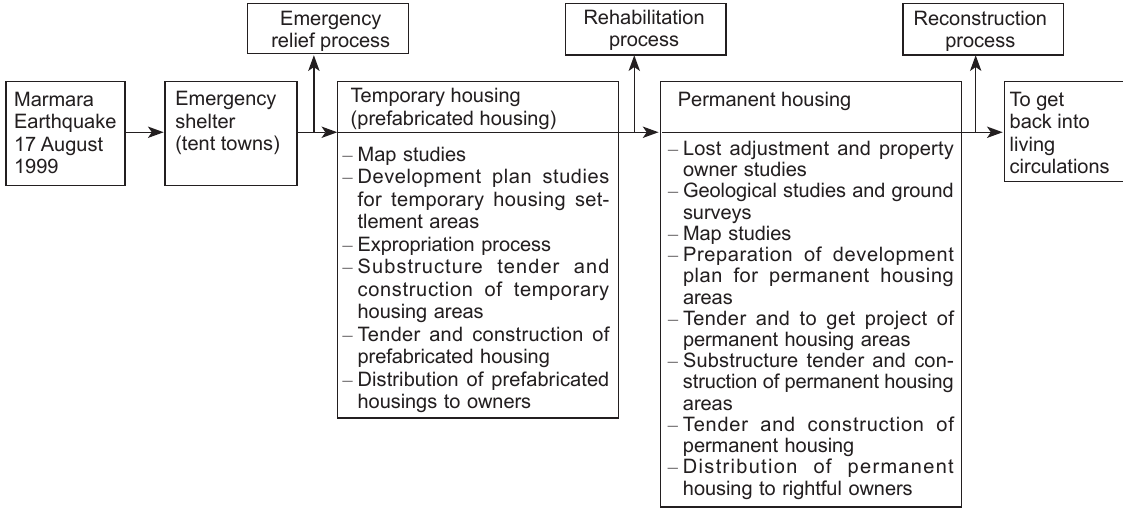
figure 6. Sheltering stages carried out after 17 august